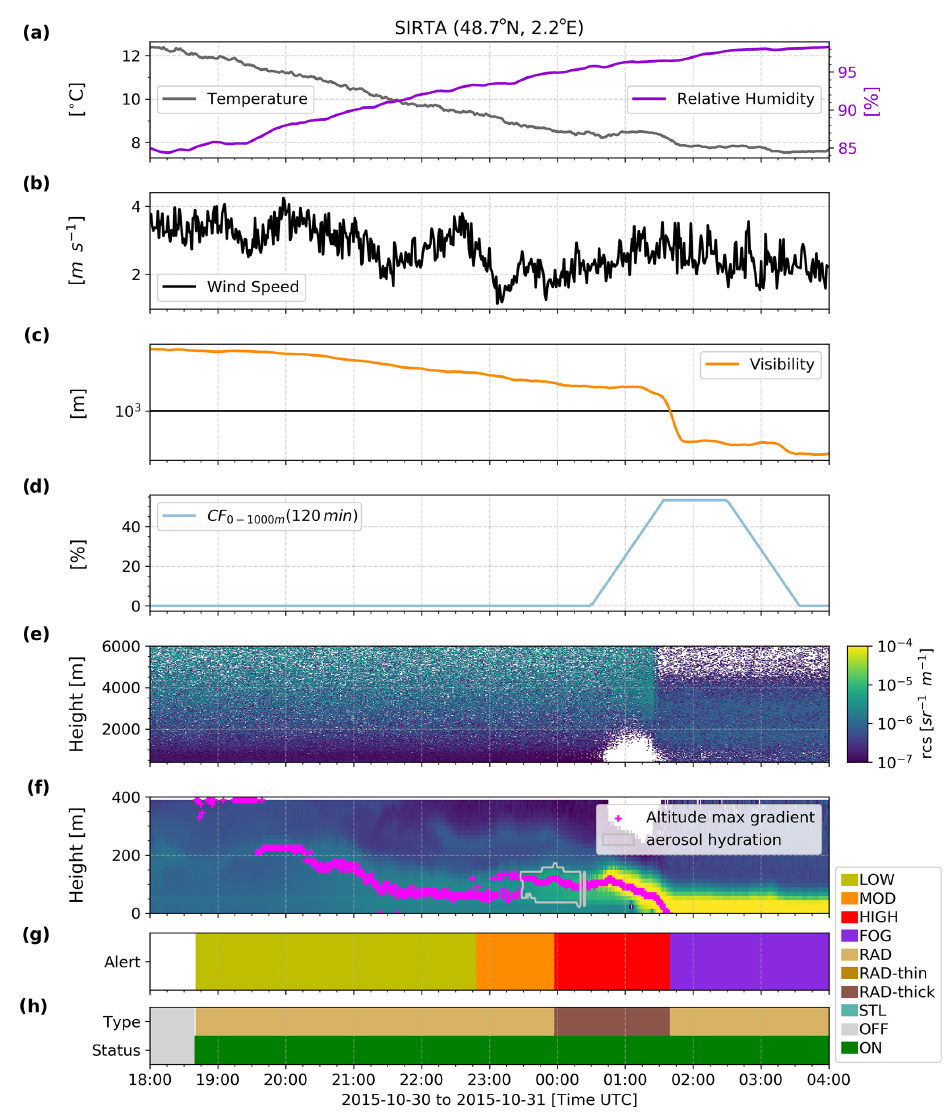
Figure 6. Time series presenting measurements and the corresponding retrieved alert level outputs from PARAFOG v2.0 during a thick radiation fog formation on 30–31 October 2015 at SIRTA. (a) Temperature and relative humidity, (b) wind speed, (c) visibility, (d) the cloud fraction (CF) between 0 and 1000m over the last 2h, (e) ALC-attenuated backscatter between 400 and 6000m, (f) ALC-attenuated backscatter between 0 and 400m (color contours), together with the altitude of the maximum gradient (fuchsia points) and the aerosol hydration (gray contours), (g) alert levels retrieved from PFG2, and (h) fog type and PFG2